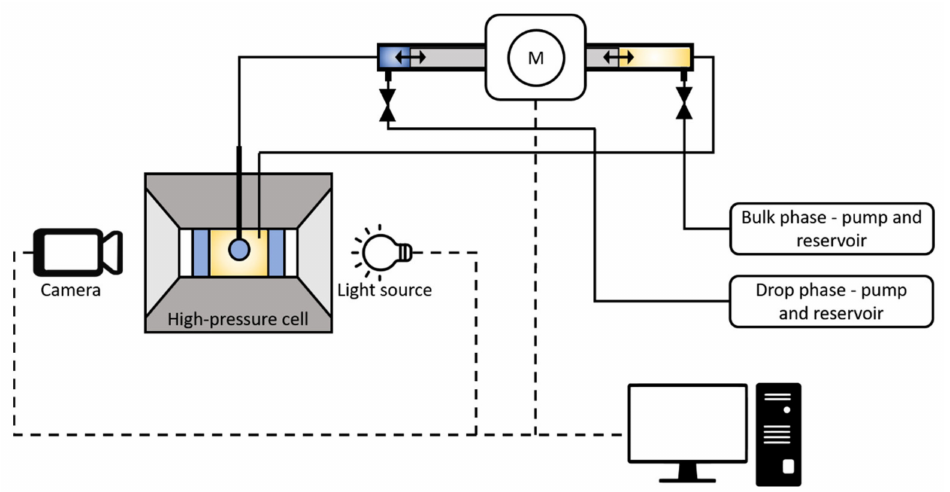
Figure 1. Schematic representation of the experimental set-up. The high-pressure cell incorporates two sapphire windows, allowing direct visu- alization, and it is surrounded by a heating element with a thermostat that allows for temperature control and covered with a thermal insulation material. The cell has two injection ports in the vertical plane, one at the top of the cell and one at the bottom. These ports allow needle tips to be installed inside the cell for the formation of an oscillating drop. In addition, there are two ports used for auxiliary purposes. The total volume of the cell is about 45 mL. The cell can operate at pressures up to 700 bar and is equipped with a heating system that allows temperatures up to 200 ◦